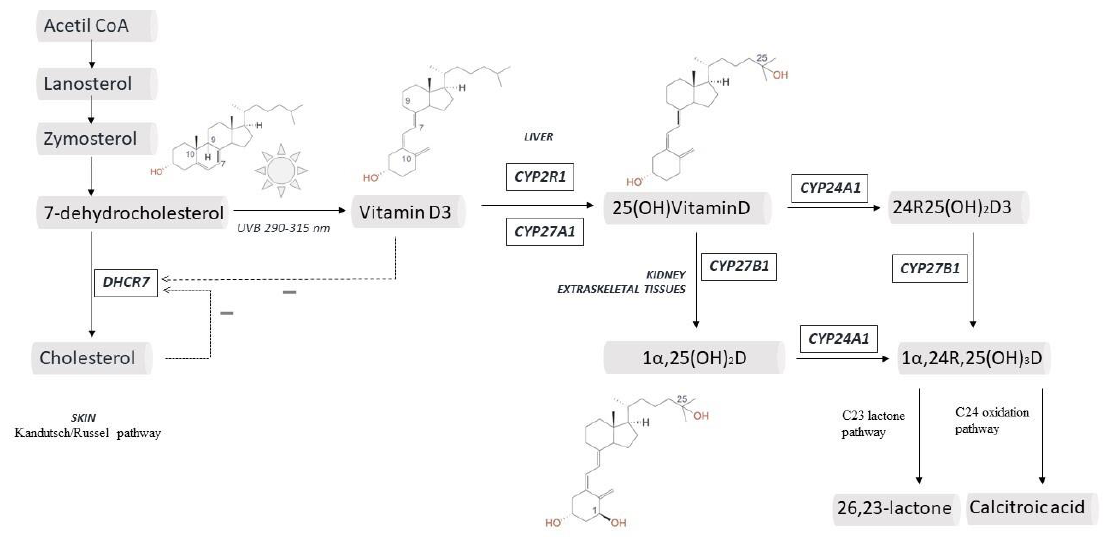
Figure 1. Crucial steps in vitamin D